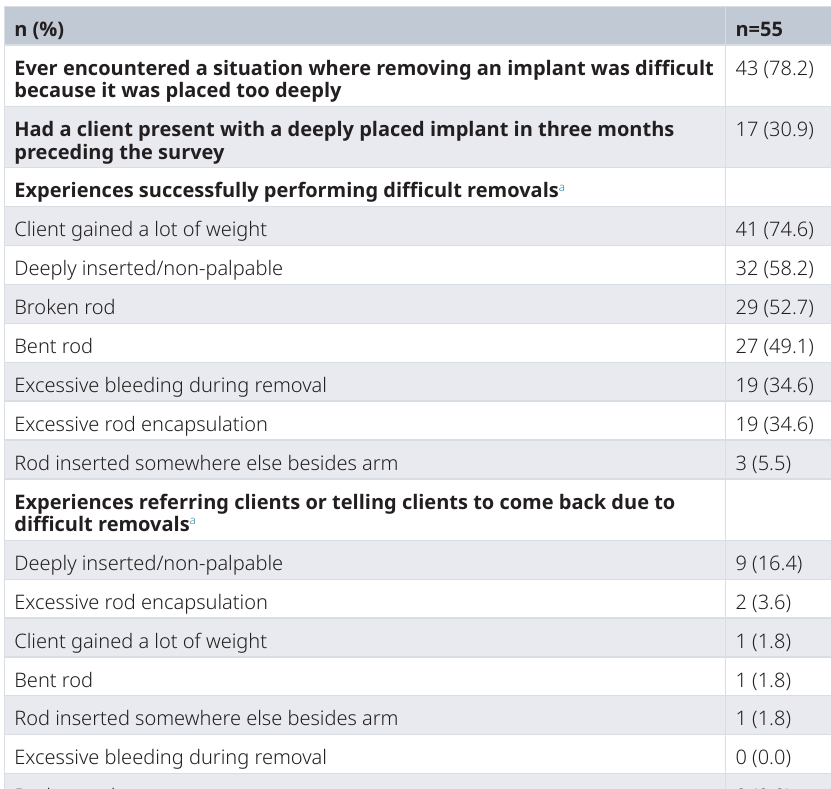
Table 4. Experiences with difficult implant removals among providers who have ever removed an